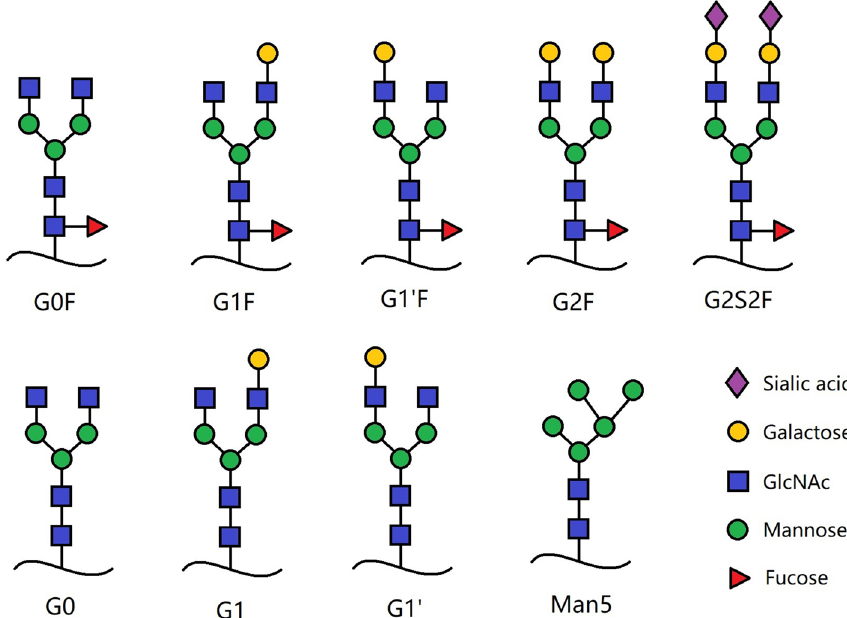
Figure 1. Major N-linked glycoforms of mAb